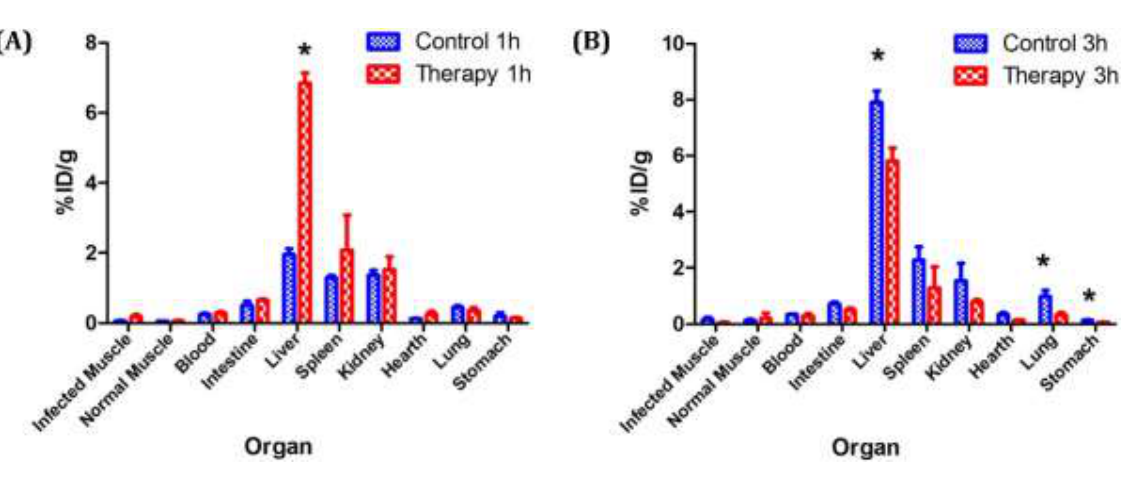
Figure 3. Ex vivo biodistribution of [ 99m Tc]Tc-ketoconazole for control (saline) and therapy group (ketoconazole) 1h post-injection (A) and 3 h post-injection (B) (n = 3). Data are presented as %ID/g ± SD, * p